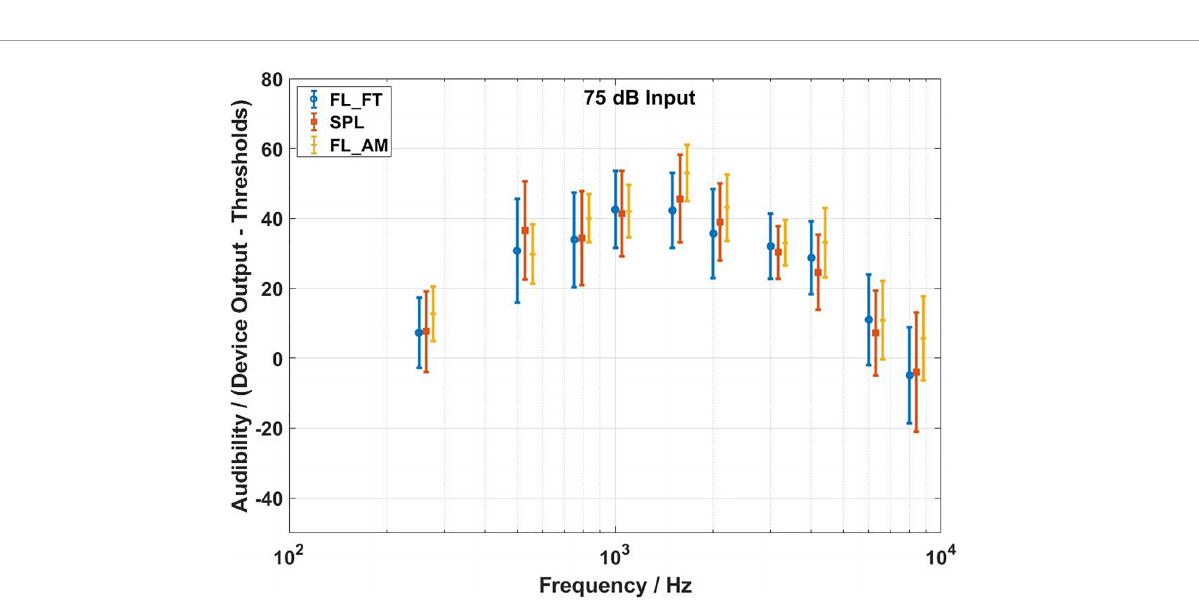
FIGURE9 Audibility estimates for the force transducer method, the ear canal method, and the artificial mastoid method at 75 dB SPL input level. Average values over all subjects. Error bars indicate ± 1 SD. The FL_FT indicates the force transducer method, the SPL indicates the ear canal method, and the FL_AM indicates the artificial mastoid method.